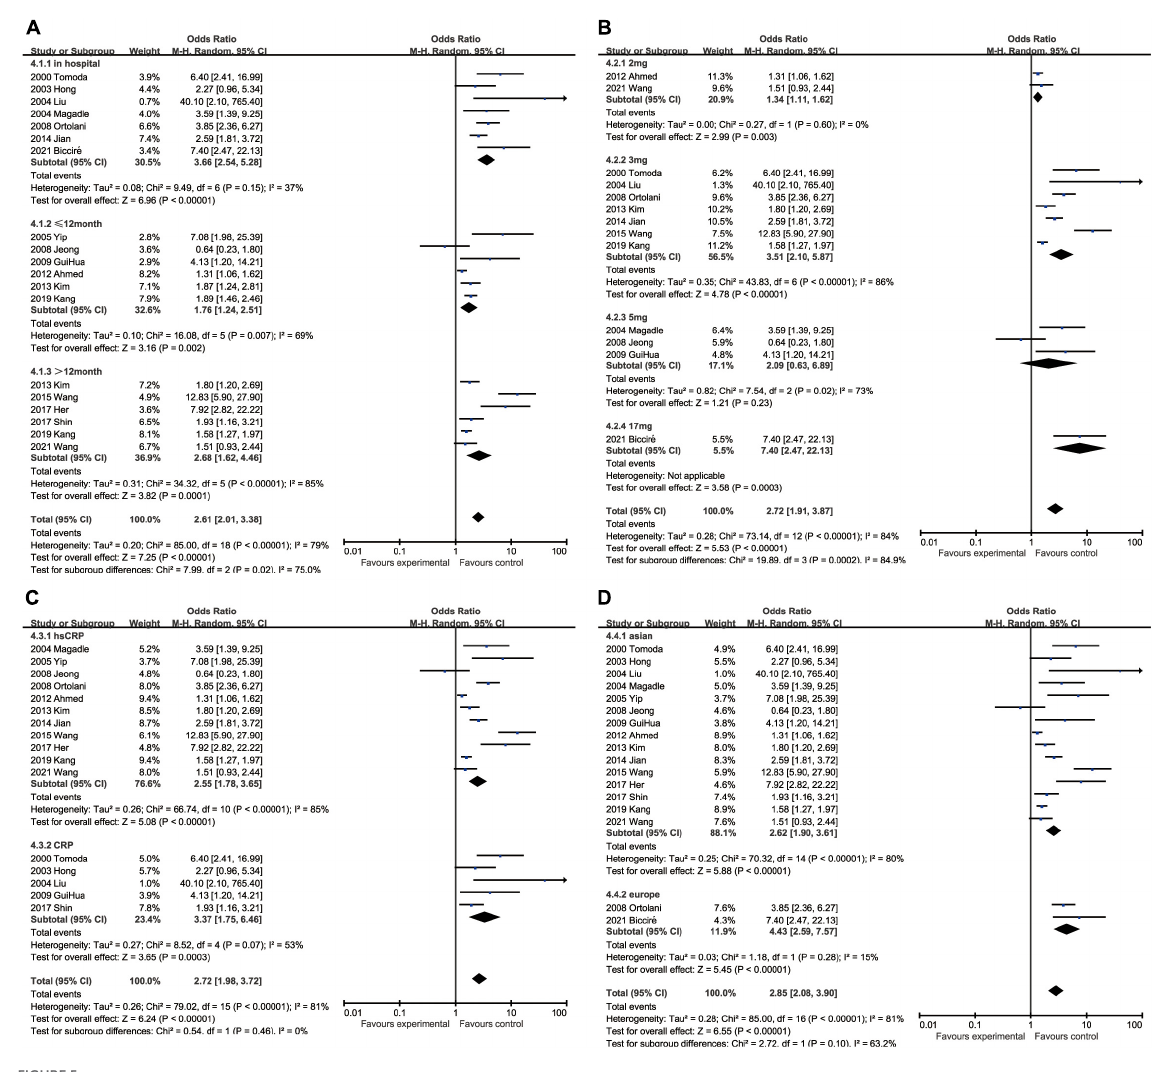
FIGURE5 Forrest plots of subgroup analysis assessing MACEs associated with increased CRP: (A) subgroups based on follow-up; (B) subgroups based on cut-off value of hsCRP; (C) subgroups based on CRP and hsCRP; and (D) subgroups based on